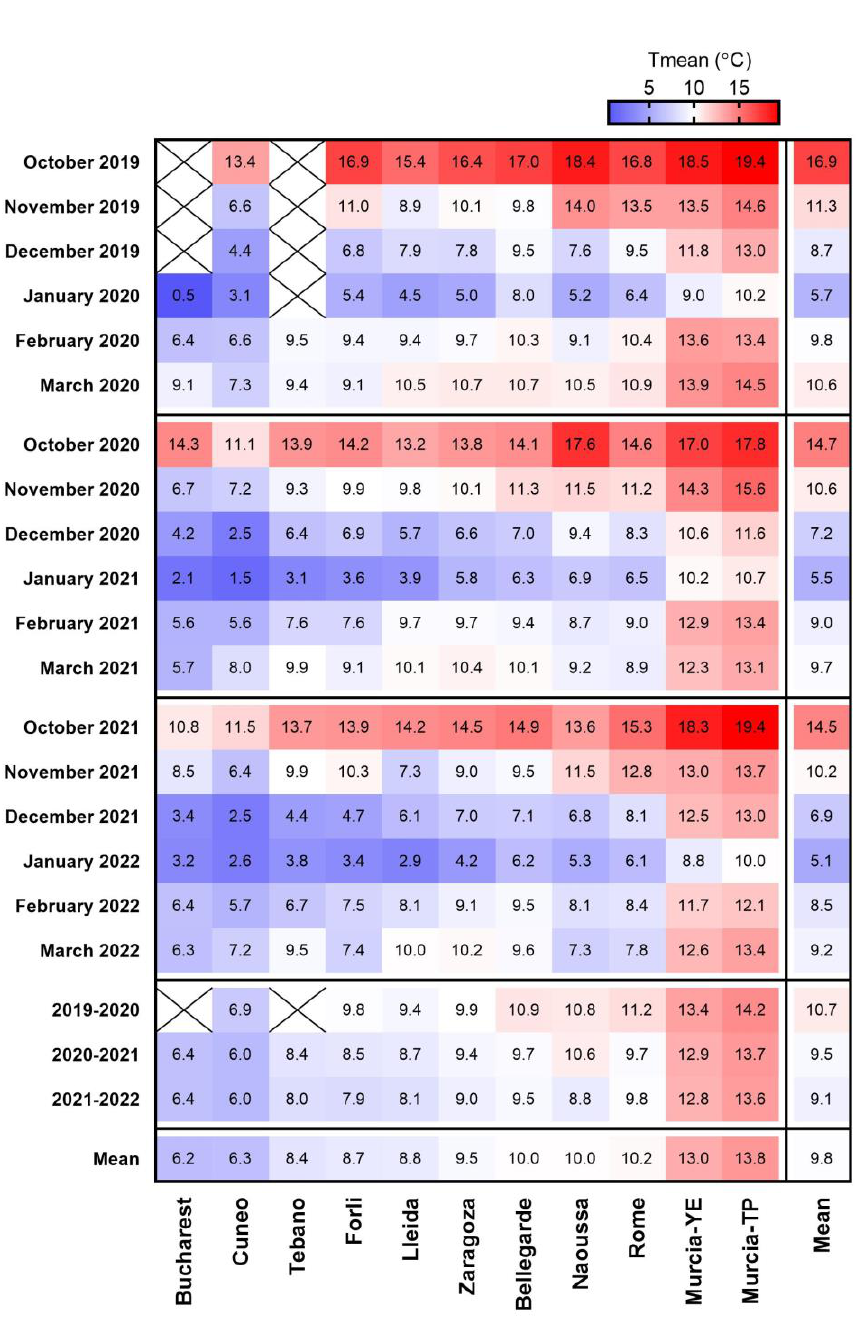
Figure 1. Heat-map presenting monthly mean temperature (°C) during October – March 2019 – 2022 in 11 European sites, presented from the coolest to the warmest. Mean values of monthly mean temperatures are presented for the above periods in each site and month. X = no data. YE = Yéchar; TP = Torre Pacheco.